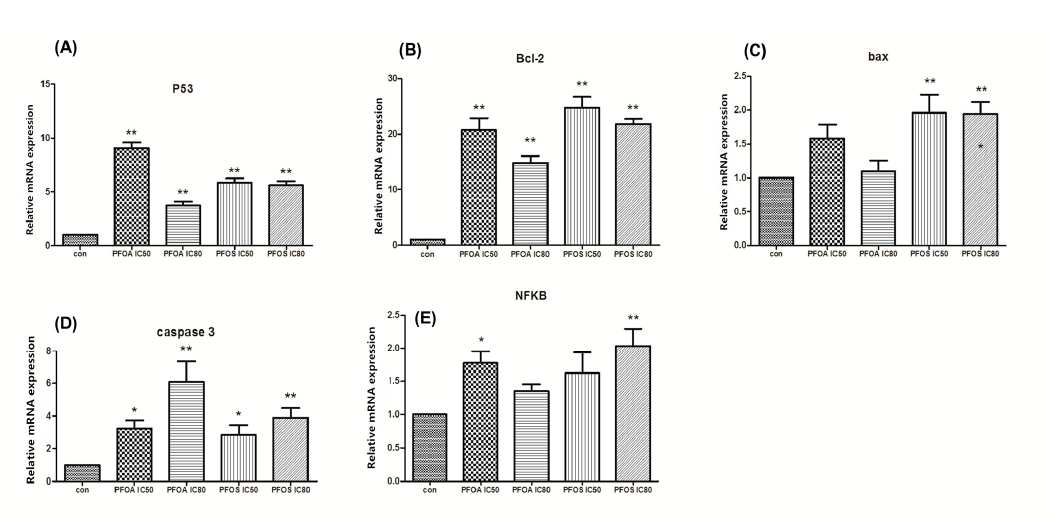
Figure 2. Relative gene expression of p53, Bcl-2, Bax, Caspase-3 and NF- κ B p65. ZFL cells were treated with PFOA or PFOS at IC 50 or IC 80 concentrations for 48 h. β -actin was used as internal control. The experiment was repeated three times. * p < 0.05, ** p < 0.01.